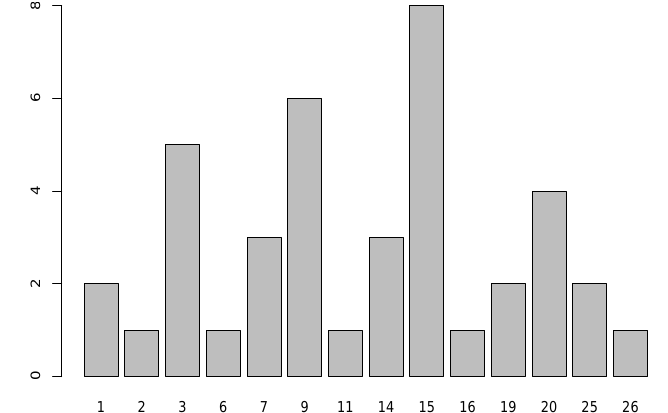
Figure 4. Bar plot of the frequencies of the inventory locations in the deterministic solutions. The x-axis represent the locations and the y-axis their frequencies in the deterministic